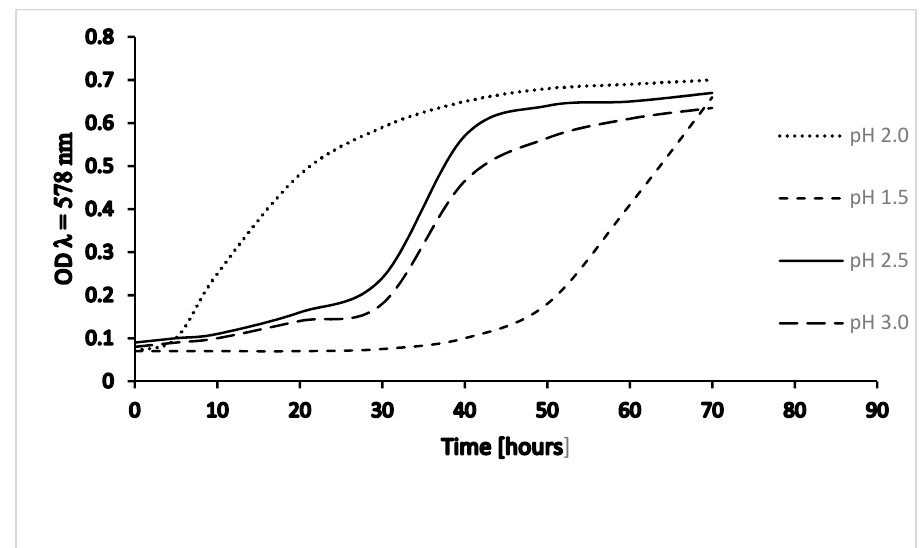
Figure 2. Culture growth of Thermoplasma acidophilum – pH dependency. Growth of T.a . DSM 1728, Göttingen, at 59 °C and varying pH; OD, optical density at λ = 578 nm; values adapted from [12].